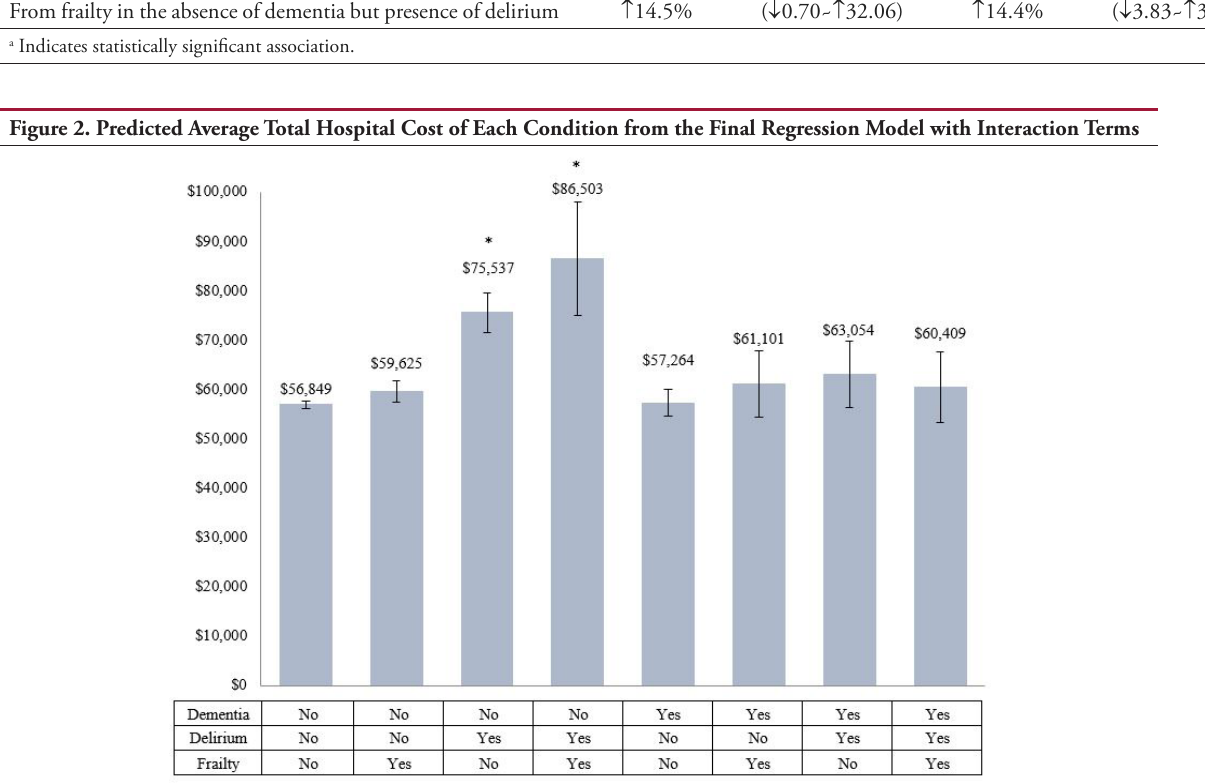
* Indicates statistically significant difference from the condition without any geriatric